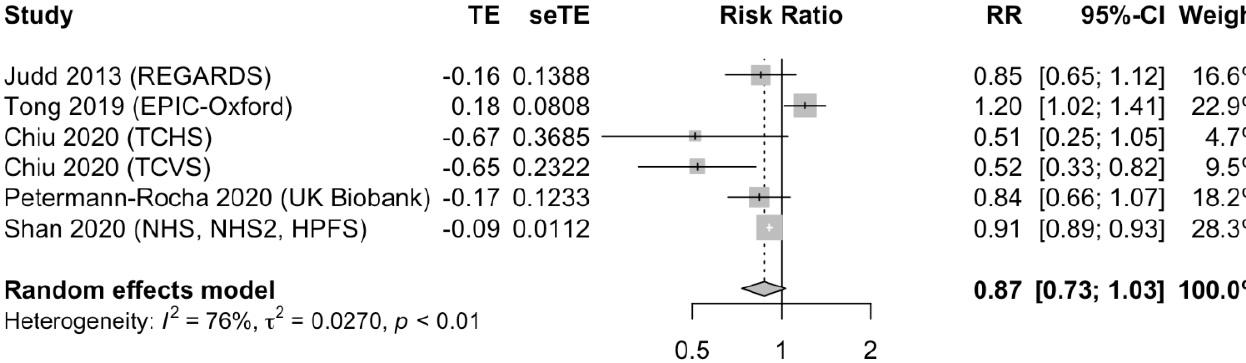
Figure 4. Forest plot of the adjusted relative risk (RR) of stroke for the highest versus the lowest adherence to plant-based dietary patterns. Pooled risk estimates and 95% confidence intervals (CI) using a random effects model for meta-analysis are in bold. Abbreviations: CI, confidence interval; EPIC, European Prospective Investigation into Cancer and Nutrition; NHS, Nurses’ Health Study, NHS2, Nurses’ Health Study II; REGARDS, Reasons for Geographic and Racial Differences in Stroke; RR, relative risk; seTE, standard error of treatment effect; TCHS, Tzuchi Health Study; TCVS, Tzuchi Vegetarian Study; TE, treatment effect; UK, United Kingdom.